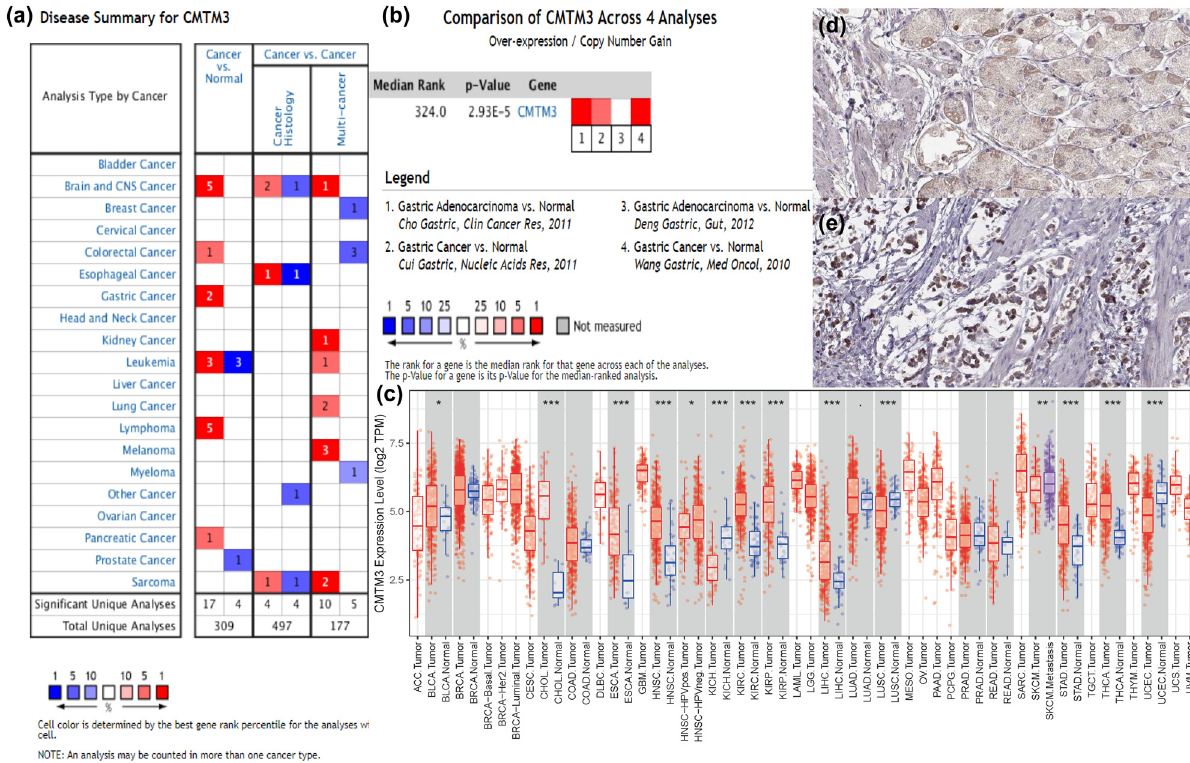
Figure 7: Expression analyses of CMTM3 by Oncomine, TIMER, and HPA databases. ( a ) The expression level of CMTM3 in di ff erent types of human tumors in the Oncomine database ( https://www.oncomine.org/resource/main.html ) . ( b ) CMTM3 is signi fi cantly overexpressed in GC using four distinct gastric cancer datasets. ( c ) The expression level of CMTM3 in di ff erent types of human tumors in the TIMER database ( https://cistrome.shinyapps.io/timer/ ) . ( d and e ) The representative protein expression of CMTM3 in gastric cancer and normal gastric tissue. Data were from the Human Protein Atlas database ( http://www.proteinatals.org )